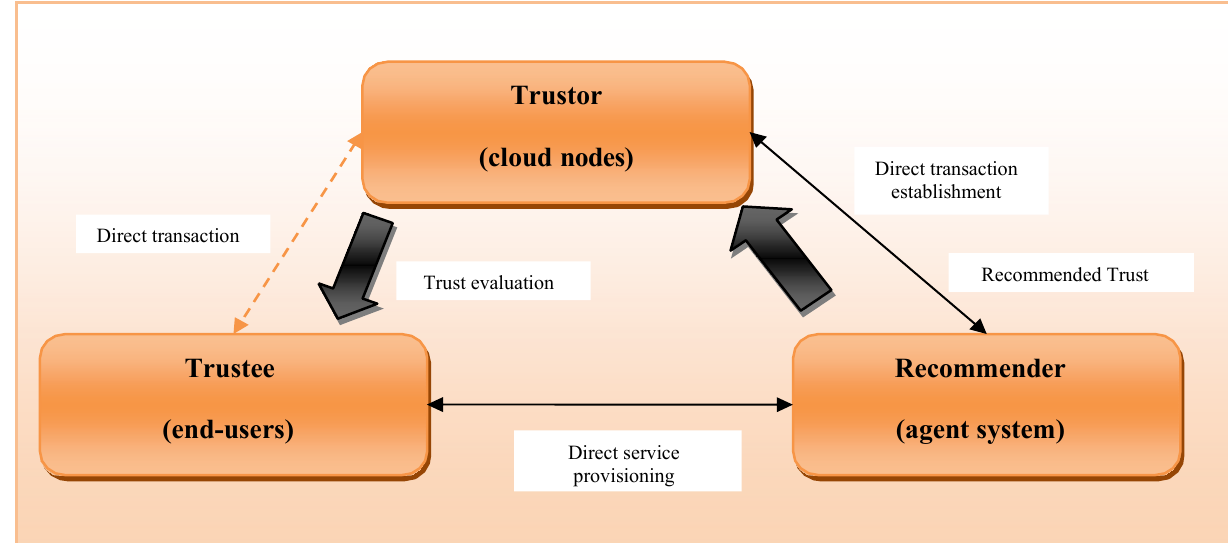
Fig 1. Traditional trust